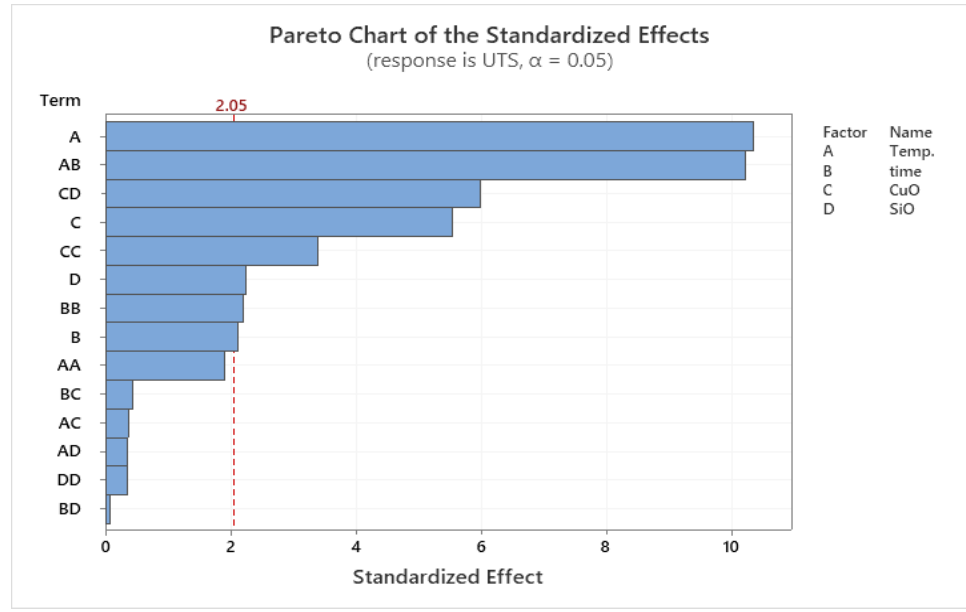
Figure 4. Pareto chart for UTS.